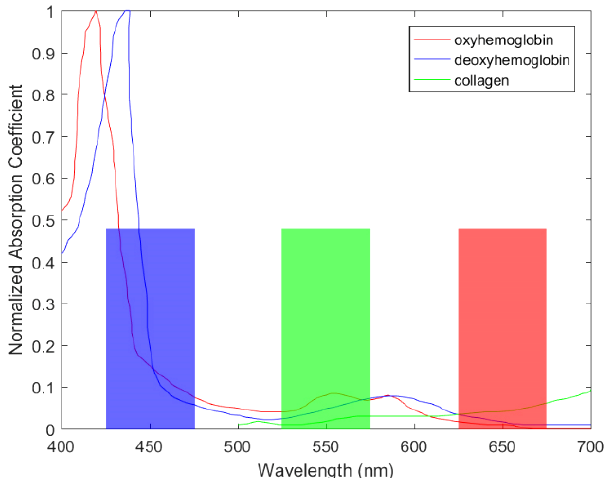
Fig. 4. The absorption spectrum of hemoglobin and collagen from 400 – 700 nm (reproduced from Refs. 51 – 57).